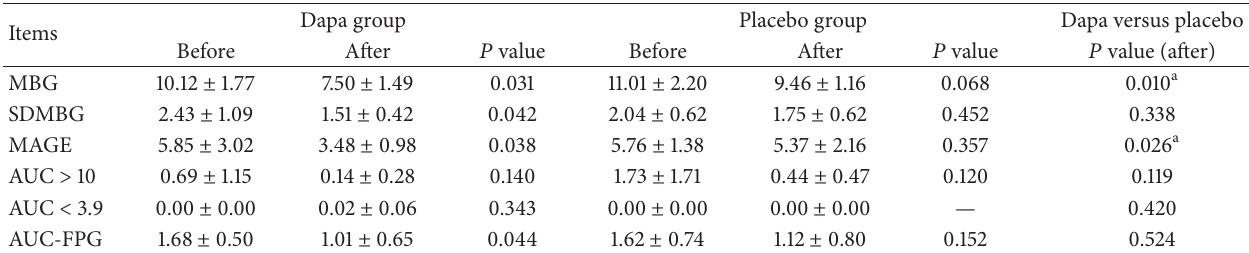
Figure 1: (a) The average blood glucose concentrations per hour levels in patients at baseline and (b) the average blood glucose concentrations per hour levels in patients after therapy. Table 1: The blood glycemic fluctuation parameters within groups. Data were presented as means ± SD. a: 𝑃 < 0.05 , dapagliflozin group versus placebo